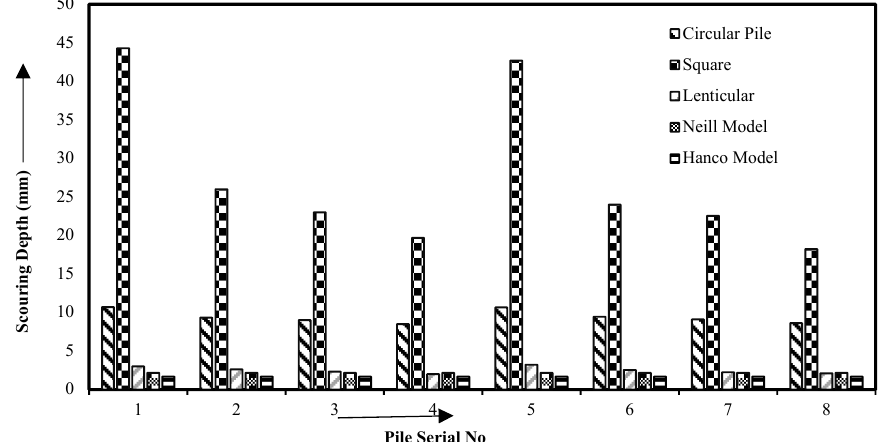
Figure 9. Comparison scouring depth at Position A with Neill and Hanco Model.